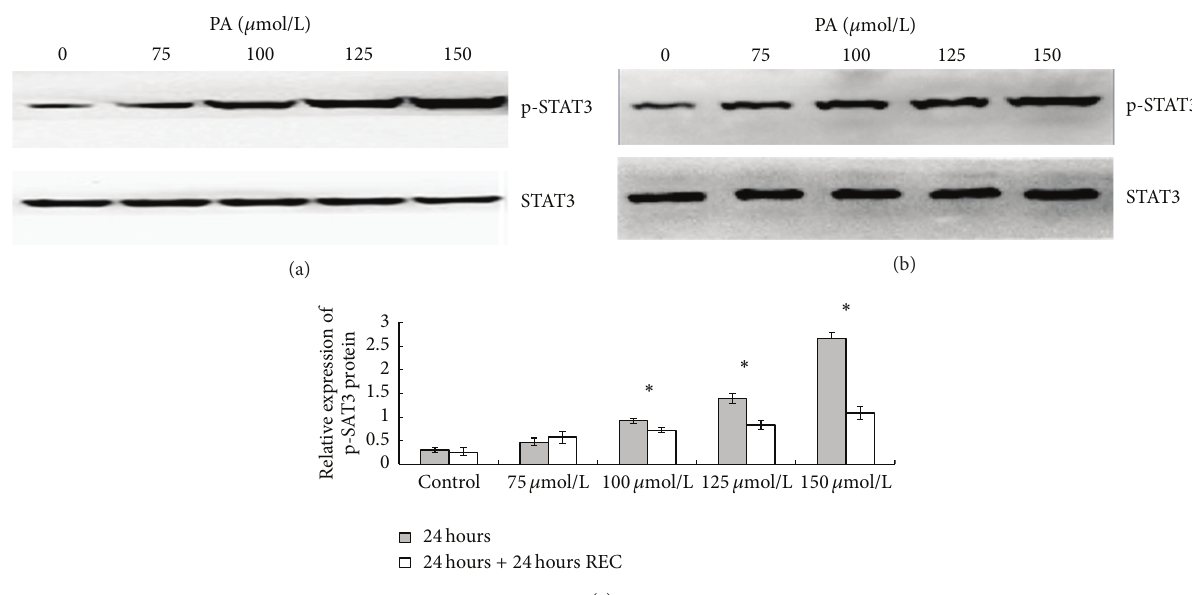
Figure 6: PA induces activation of p-Stat3 (Tyr705) in HaCaT cells measured by western blotting. Keratinocytes were untreated or treated with PA (75, 100, 125, and 150 𝜇 mol/L) for 24 hours under serum-free conditions. The cells were harvested, and nuclear extracts were analyzed with p-Stat3 and total Stat3 by western blot immediately after the treatment (a) and 24 hours after the PA depletion (b). The densitometry values are means ± SD of three independent experiments (c). Asterisks ( ∗ ) indicate significant differences of 𝑃 < 0.05 , respectively, between the PA-treated groups and nontreated group.